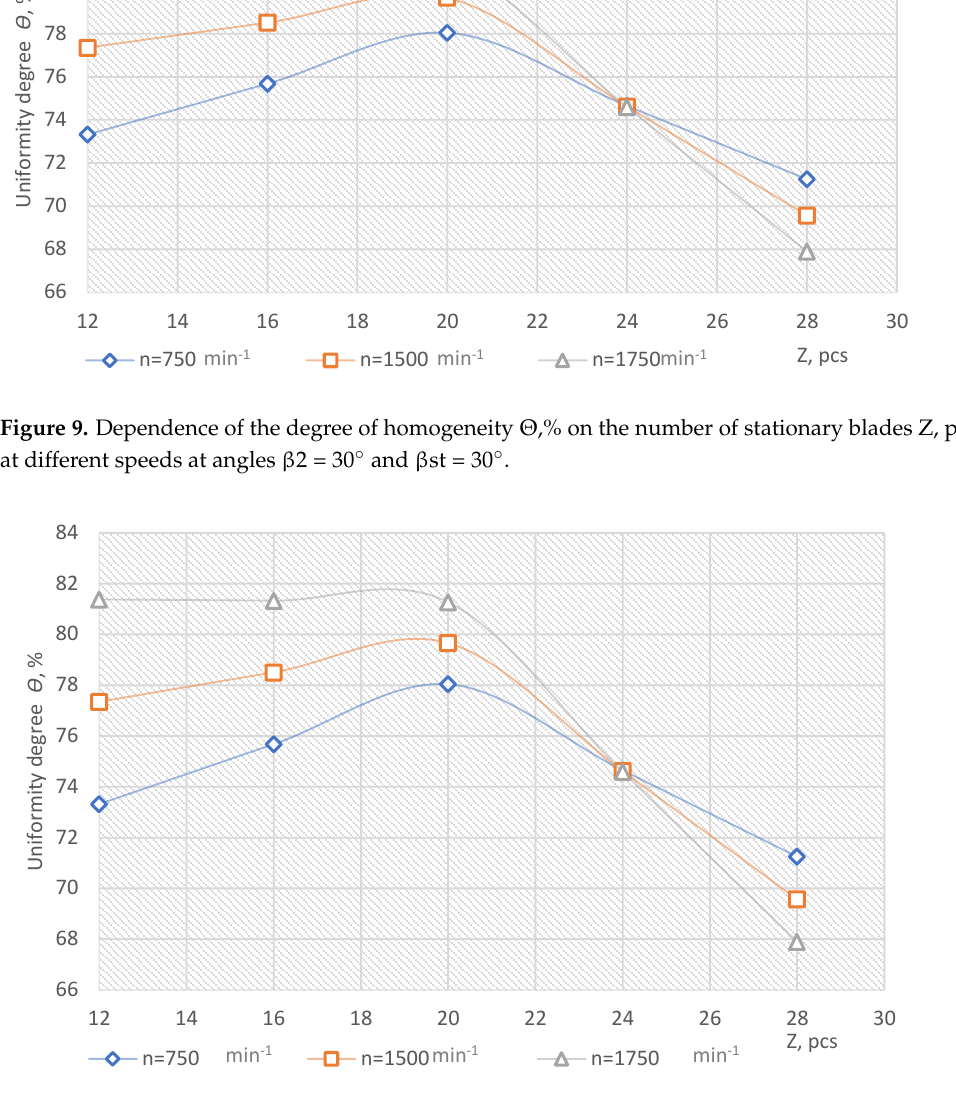
Table 1. Plan of the experiment to determine the optimal parameters 2.